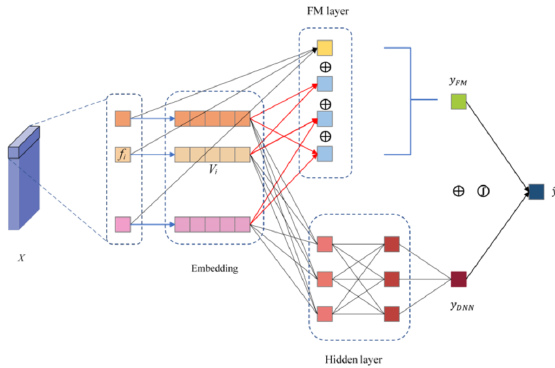
Figure 3. The structure of the DeepFM